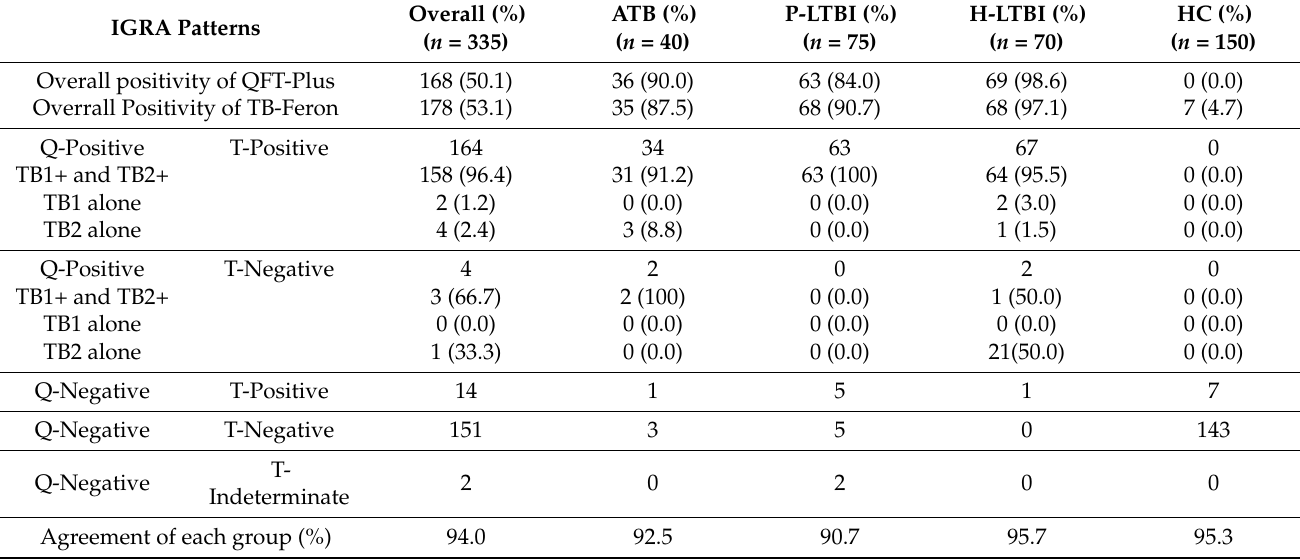
Table 2. Distribution of QFT-Plus and TB-Feron IGRA results and agreement between the